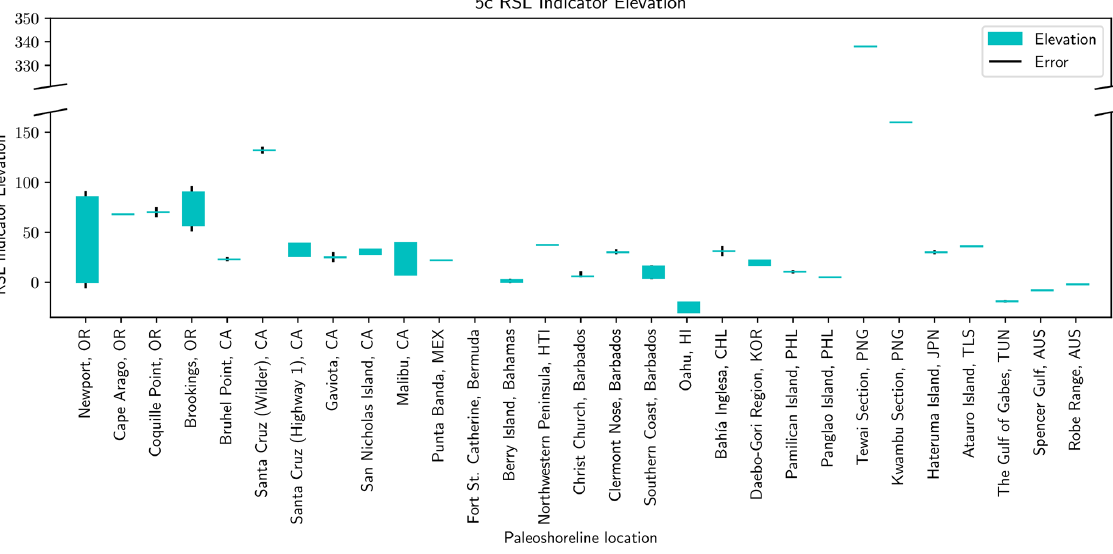
the Bruhel Point terraces vs. inferred ages (uplift-rate dia- grams) to the New Guinea sea level curve (see Sect.